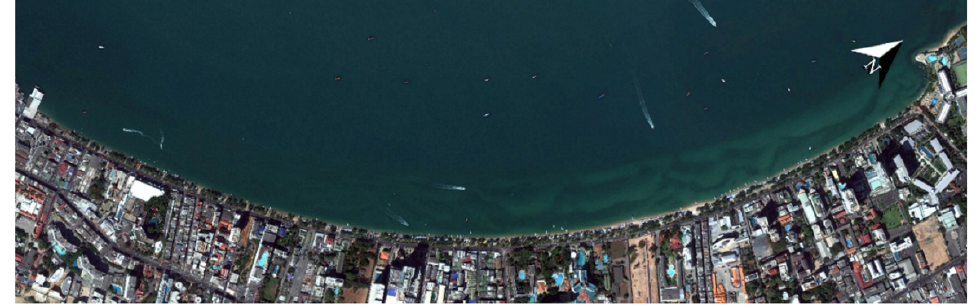
Figure 2. Pattaya beach.